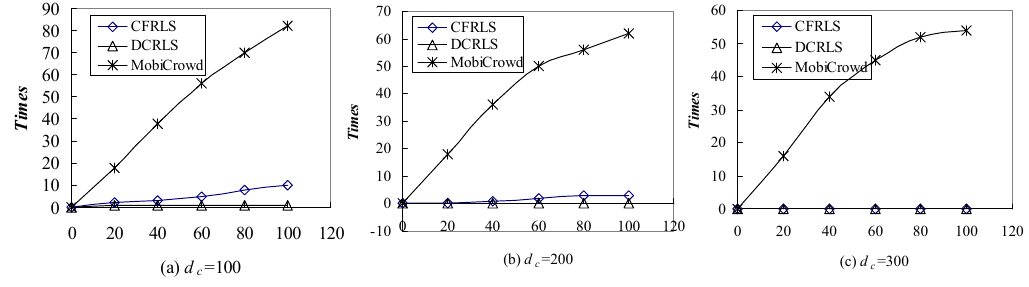
Figure 12. Comparison of the access server number with different algorithms.